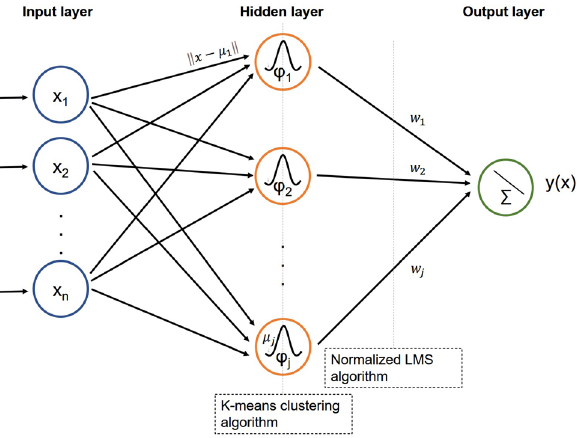
Figure 3. Schematic of the radial basis function neuron